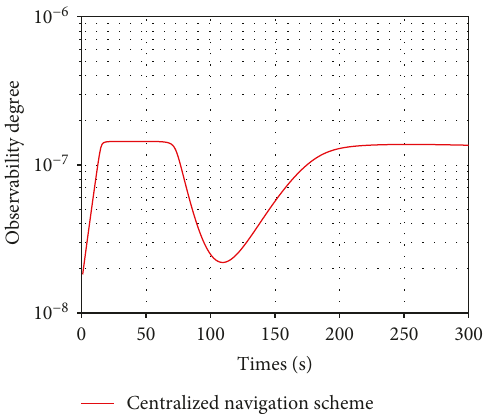
Figure 2: Observability degree of the centralized navigation system.